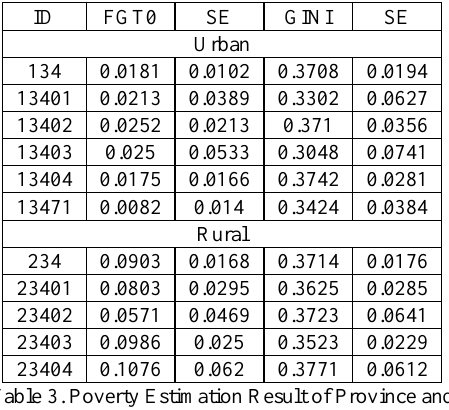
Table 3. Poverty Estimation Result of Province and